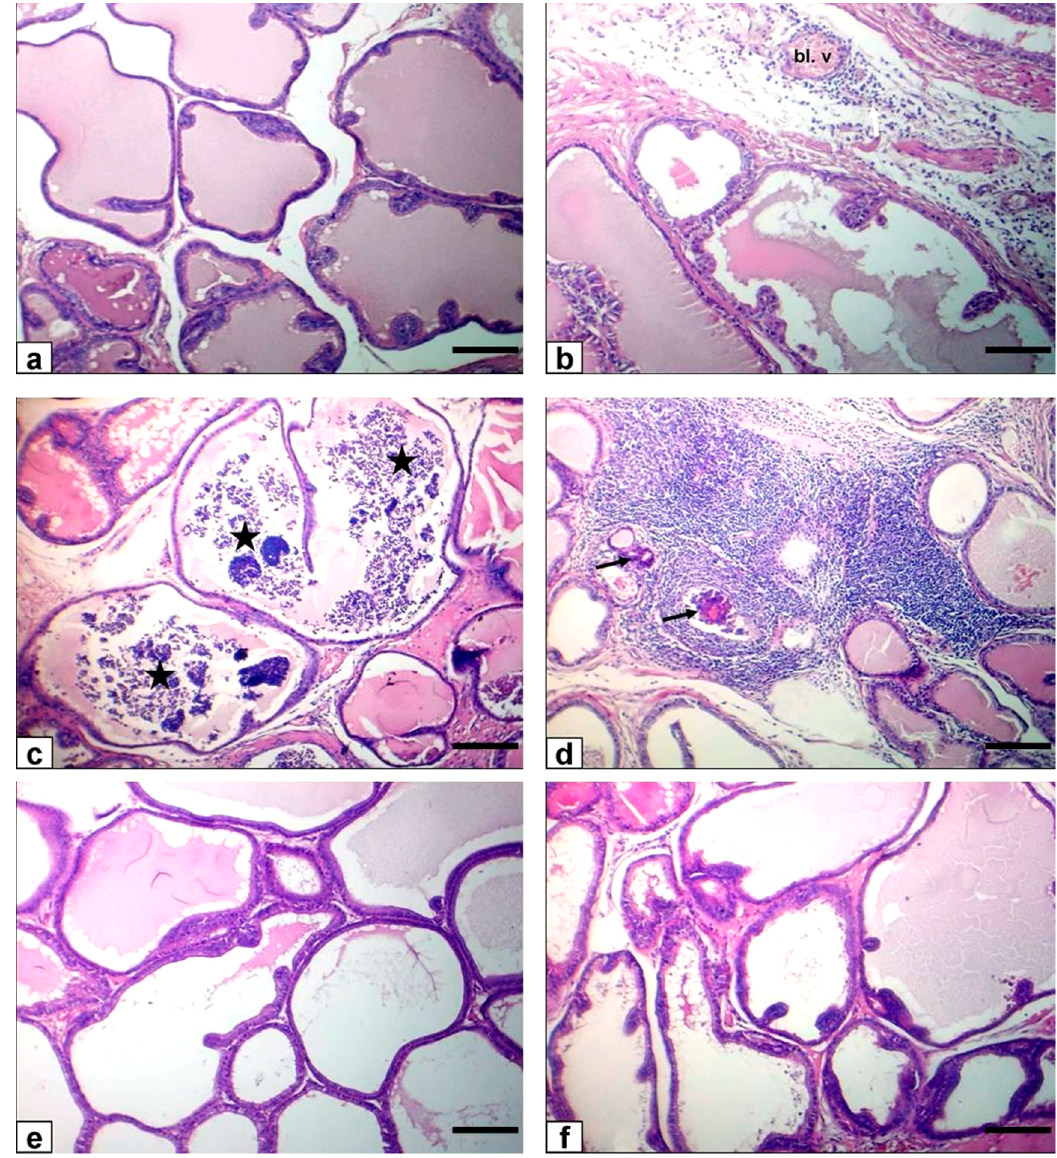
Figure 4. Photomicrograph of rat prostate stained with HE. Bar = 100 µm). ( a ) A prostate of control rats with the normal histological structure of the glandular epithelium and normal luminal secretions. ( b – d ) FPN-treated rats showing interstitial congestion (Bl. v) and perivascular inflammatory cell infiltration (white arrow) with low luminal secretions beside the desquamation of glandular epithelium (stars) and severe leukocytes in the interstitium with necrosis of glandular acini (black arrows). ( e ) FPN + BA 1 rats showing normal histoarchitecture of glandular epithelium and moderate luminal secretions. ( f ) FPN + BA 2 rats showing nearly normal histoarchitecture and moderate luminal secretions.